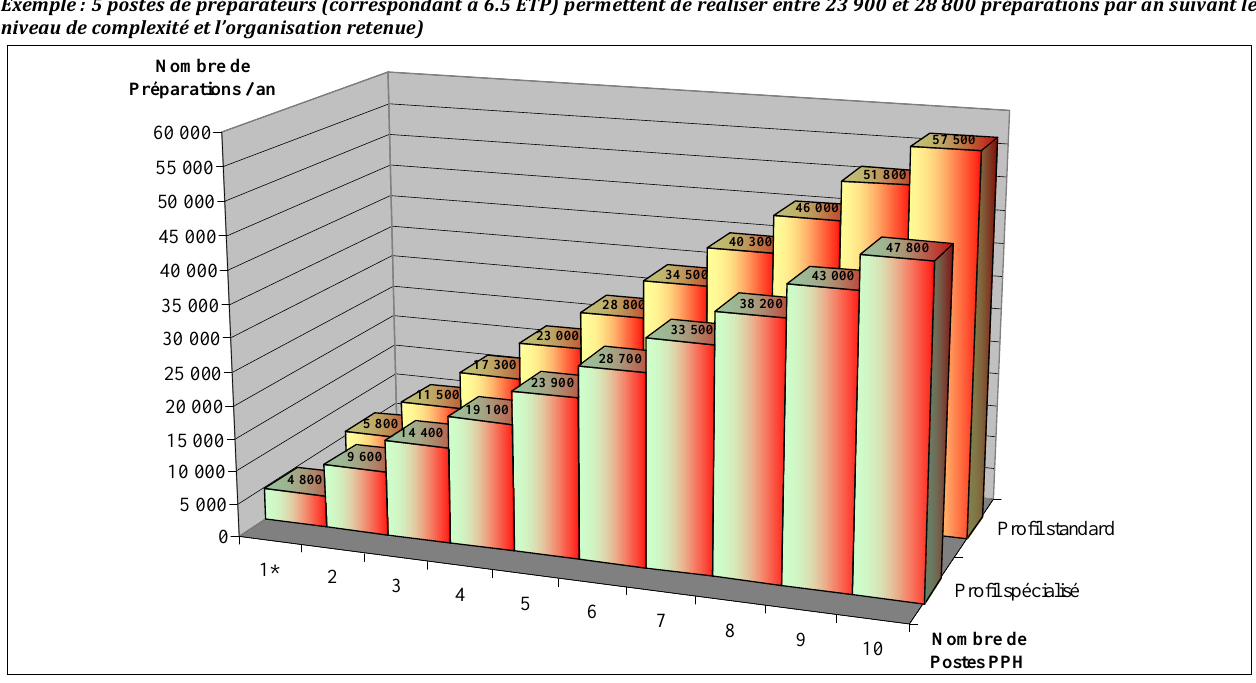
Figure 1 : Seuils d’activité redéfinis selon les 2 profils extrêmes d’unités de préparation (standard N°1 et spécialisé